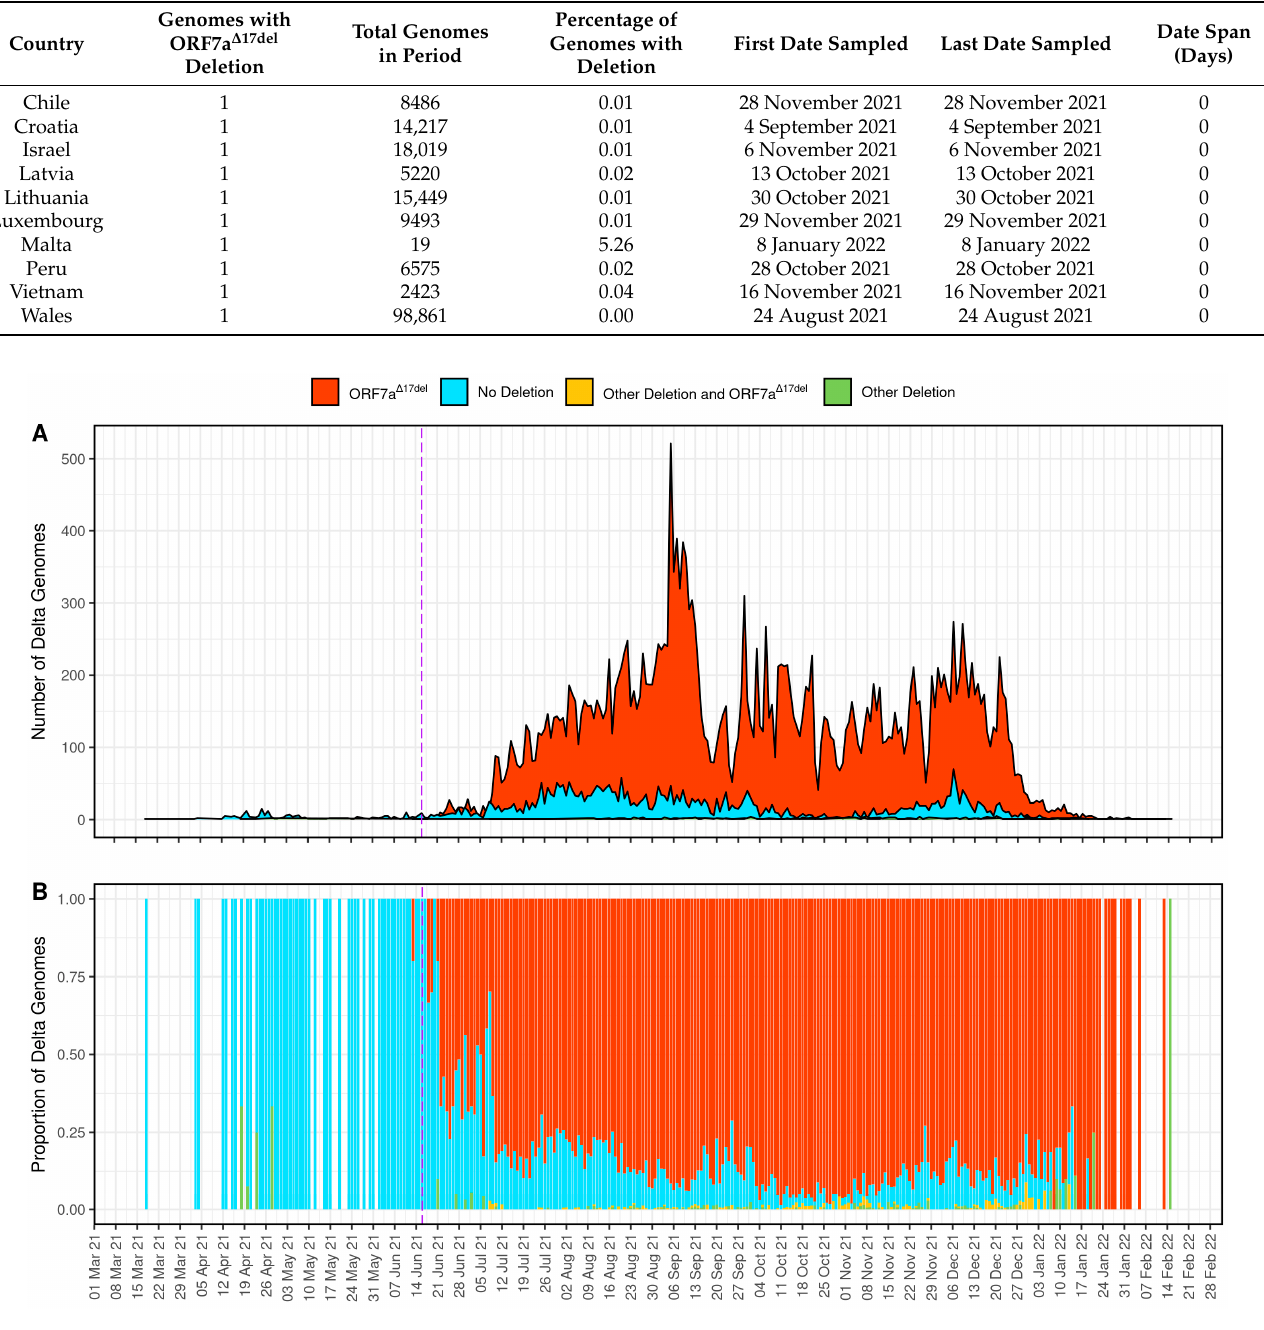
Figure 2. Time series plots of 32,048 genome sequences from the Australian Delta outbreak which show the number ( A ) and proportion ( B ) of genomes per day that possessed the characteristic deletion of 17 nucleotides within ORF7a spanning genomic positions 27607–27623 (ORF7a ∆ 17del ), any other deletion in ORF7a, any other deletion in ORF7a plus ORF7a ∆ 17del , or no deletion in ORF7a. The purple dashed line indicates the beginning of the Australian Delta outbreak. Accession numbers for all the samples that were analysed for this panel are available in Table S1 and https://doi.org/10.55876/gis8.220809bs. Table 2. All countries that generated genomes possessing the deletion that characterised the Australian Delta outbreak (ORF7a Δ 17del ) during the outbreak time period, as determined by analysis of all Delta genomes in GISAID clade GK (as of 31 May 2022). The genomes either possessed ORF7a Δ 17del as the sole deletion in ORF7a, or it was one of two or more deletions in the gene. The table is ranked by the number of genomes with ORF7a Δ 17del . The percentage of Delta genomes submitted to GISAID during the time period that had ORF7a Δ 17del is given to two decimal places. Note: a date span of 0 days suggests that genome(s) were collected on a single date. Accession